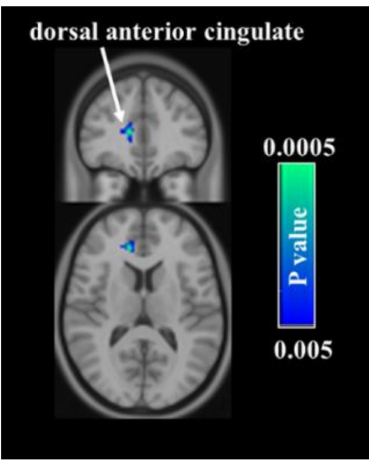
Figure 2. Comparison of cerebral blood flow (CBF) between two time-points in the verum group. Voxelwise analyses demonstrate a decrease in CBF in the right dorsal anterior cingulate cortex after